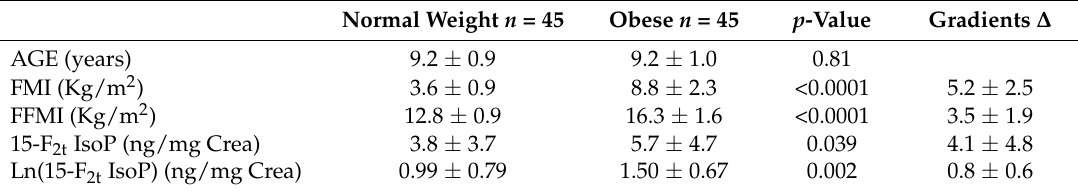
Table 3. Subgroup of children categorised as NW and OB by all standards simultaneously. Normal Weight n = 45 Obese n =